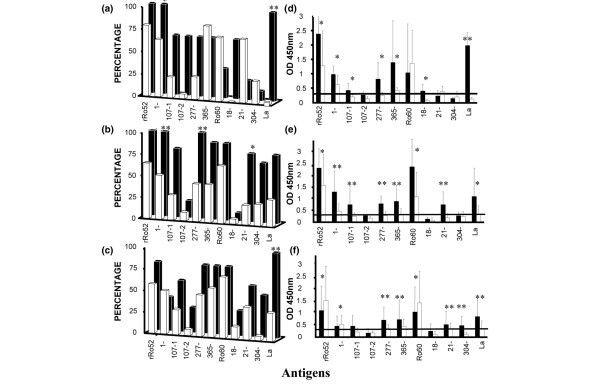
Reactivity in ELISA of sera from lupus mothers of groups I and II with Ro antigens. Sera were classified into three subgroups: (a), (d) before, (b), (e) during, and (c), (f) after pregnancy. The results are expressed in terms of frequency (%) of positive reaction ((a)–(c)) and antibody level (mean optical density [OD] values + standard deviation) ((d)–(f)). Mothers' sera were tested at a 1:1,000 dilution and the IgG response only was evaluated. The number of samples (number of mothers) was as follows; group I (black bars): (a)–(d), 5 (3); (b)–(e), 8 (5); (c)–(f), 6 (5); group II (white bars): (a)–(d), 18 (4); (b)–(e), 44 (16); (c)–(f), 12 (7). All samples were systematically tested in at least two independent tests. The results shown in the figure correspond to one complete representative experiment. The sera were considered positive when OD ≥0.3 (visualized by a longitudinal lane in panels (d)–(f)). All sera were tested with the 48 antigens. Only the Ro antigens showing reactivity are depicted. For clarity, the first residue of each peptide sequence is indicated in the figures (107-1 for 107–122; 107-2 for 107–126). (a)–(c) Student's t test, *0.05 > P > 0.01, **P ≤ 0.01; (d) and (e) Mann-Whitney U test, *0.05 > P > 0.005, **P ≤ 0.005.